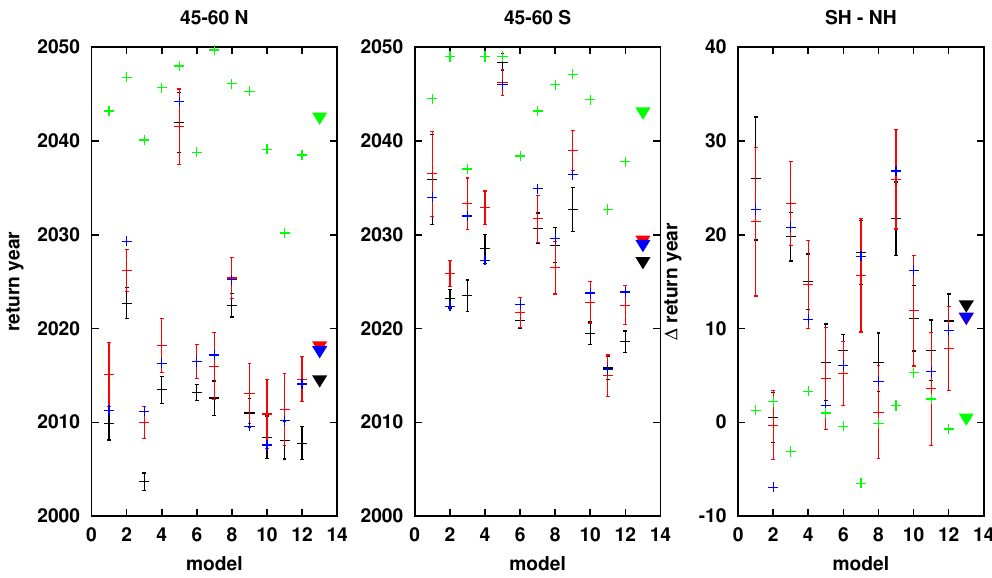
Fig. 1. Return dates to 1980 values of mid-latitude total column ozone for twelve different CCMs using a simple regression (black, with uncertainties), using advanced regression (red, with uncertainties) and smoothing (blue) together with 50hPa Cl y return dates (green). Triangles on the right are the multi-model mean. Left panel: NH mid-latitudes (45–60 ◦ N), middle: SH mid-latitudes (45–60 ◦ S) and right: SH −